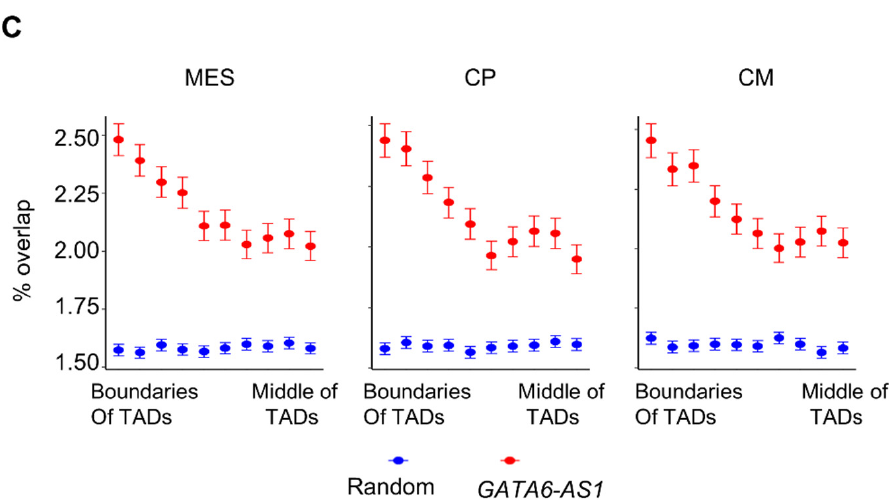
Figure 1. Enrichment of lncRNA GATA6-AS1 triplex sites in specific regions in the context of 3D genome organization. The distribution of expected coverage (blue) compared to the observed coverage (vertical red line) in TAD domains and TAD boundaries are shown in panels ( A , B ), respectively. The x -axis and y -axis represent coverage (in kb) and frequency, respectively. ( C ) Enrichment of GATA6-AS1 triplex sites at different regions in TADs. A TAD was divided into 10 regions or bins based on distance from the boundary. The y -axis represents the fraction of the size of the bin that was occupied by GATA6-AS1 triplex sites (or a control set of randomized sites). The error bars indicate the standard error of the mean.